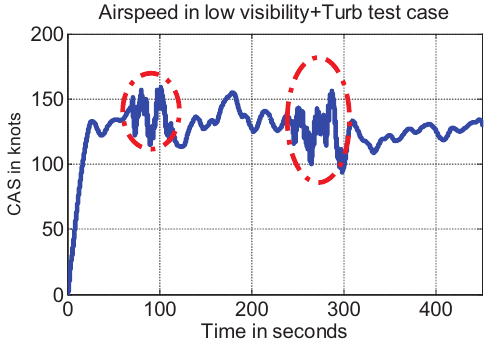
Figure 13. Airspeed in P3 test